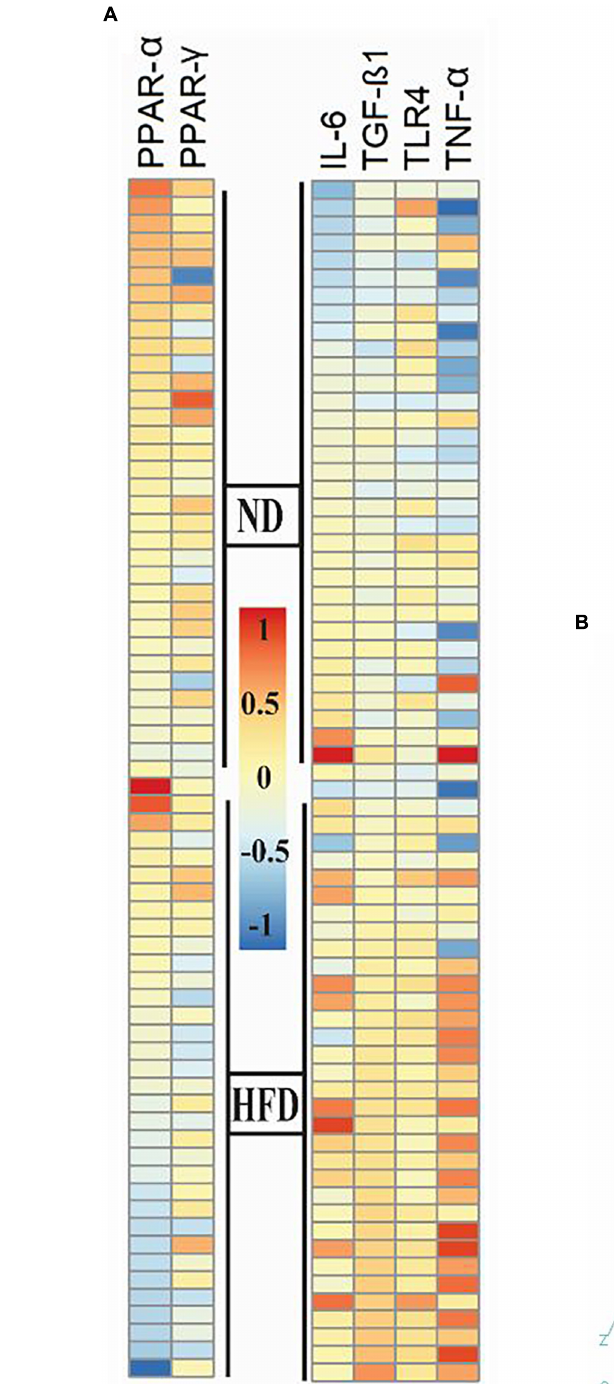
Frontiers in Microbiology |